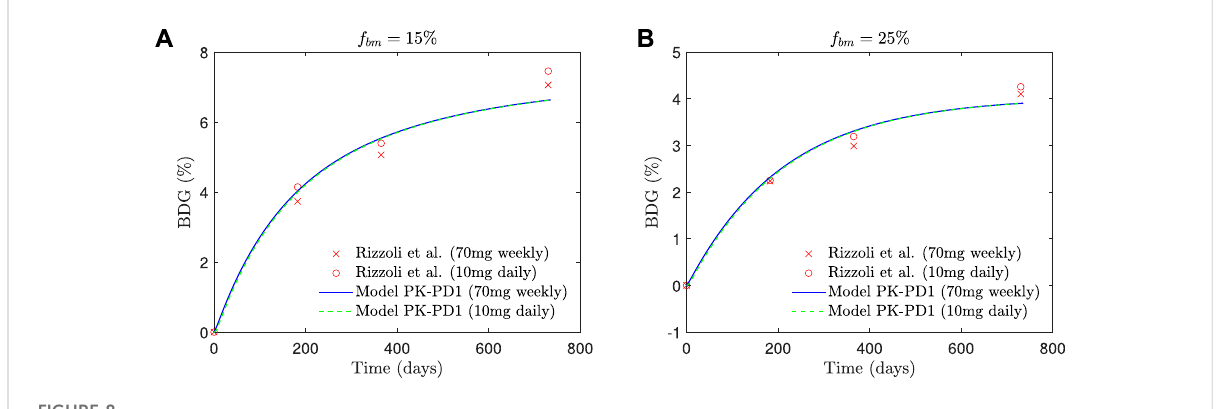
FIGURE 8 Comparison of BDG vs. time plots of alendronate PK-PD1 model for (A) hip, that is, f bm = 15% and (B) lumbar vertebra, that is, f bm = 25% for a once-weekly 70 mg dose and daily 10 mg dose with the clinical results obtained by Rizzoli et al. (2002).